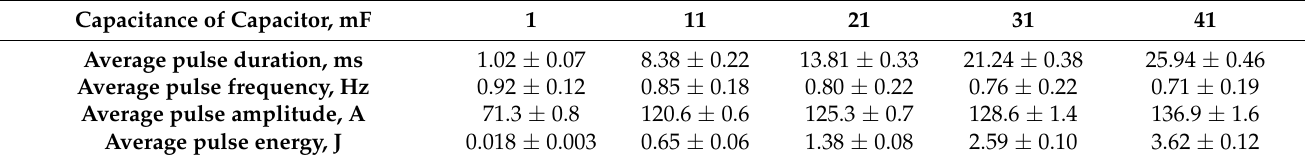
Table 1. Dependence of the characteristics of electrical discharges on the capacitance of the